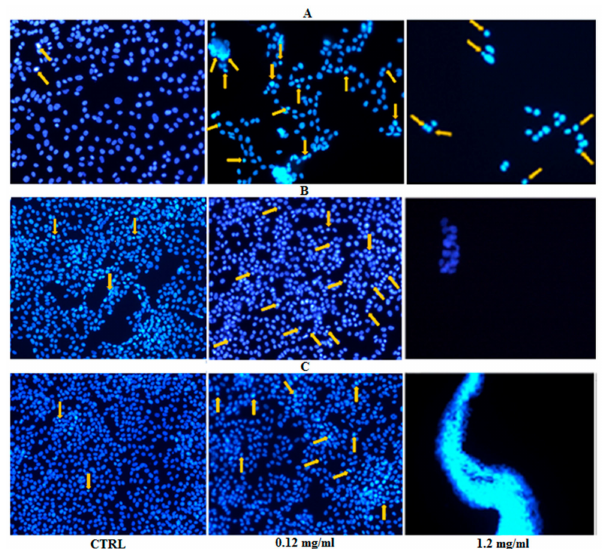
Figure 10. Hoechst 33258 staining in BRL-3A hepatic cells after 6 h ( A ), 24 h ( B ), and 48 h ( C ) of treatment with two concentrations of J. curcas genotype B. Figures are representative of five replicates for each sample. Original magnification: ×